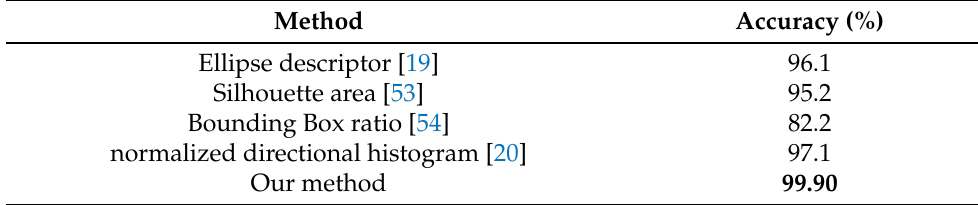
Table 10. Comparison of different features extraction